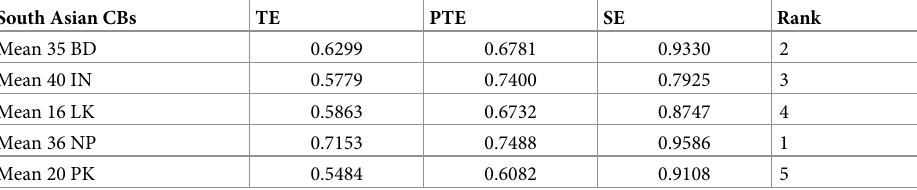
Table 5. Mean operational efficiency scores of each country’s CBs (2013–2018).